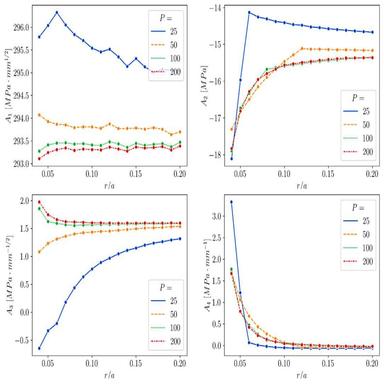
Convergence distance from the crack tip for 1 ,… , 4 depending on different e and .